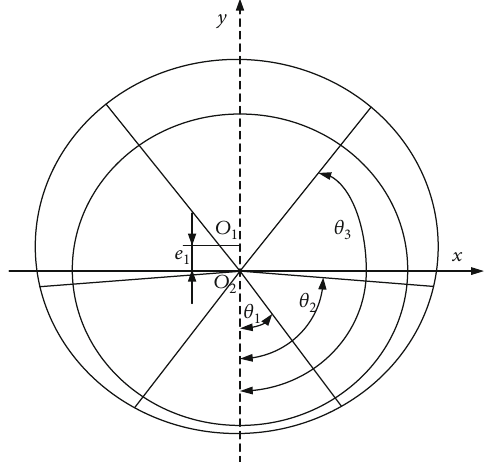
Figure 19: Interaction area between contamination particles and side valve